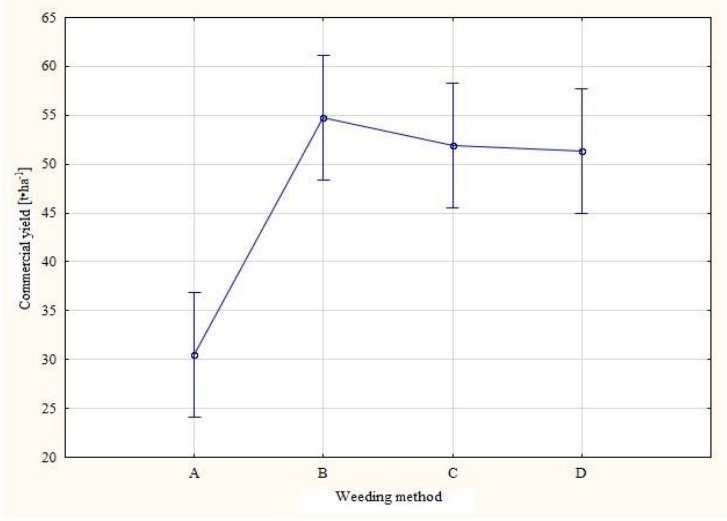
Figure 13. Expected marginal averages for 0.95 confidence intervals in commercial onion yield in 2018 (source: own work).